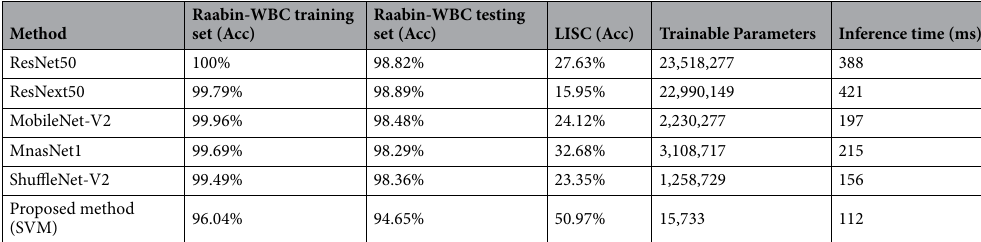
Table 7. The comparison of the pre-trained models and our proposed method in terms of generalization ability, trainable parameters, and inferencing time. Acc, and ms are the abbreviations of accuracy and millisecond,